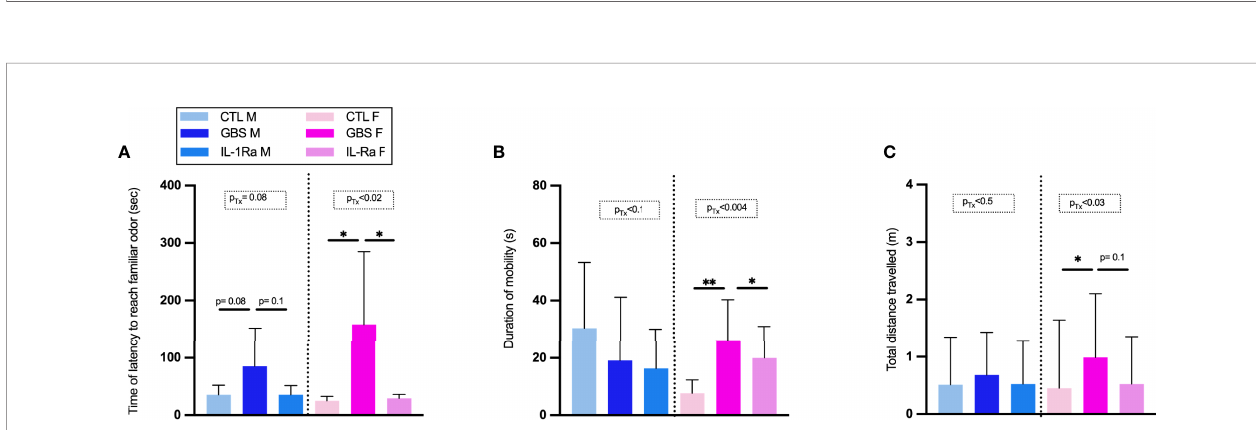
FIGURE 6 | Litter size and fetal mortality. Mean number of alive fetuses per litter (A) , percentage of dead fetuses per litter (B) . Number (n) of litters: CTL (n = 6), GBS (n = 9) and, GBS plus IL-1Ra (n = 7). Data were collected from four individual experiments. Analyses were done by ANOVA test separately for males and females. Dunnett ’ s multiple comparisons were done between groups (CTL, GBS, and GBS plus IL-1Ra). Bars show mean ± SEM. GBS, group B Streptococcus ; IL-1Ra, IL-1 receptor antagonist; n, number; SEM, standard error of the mean.